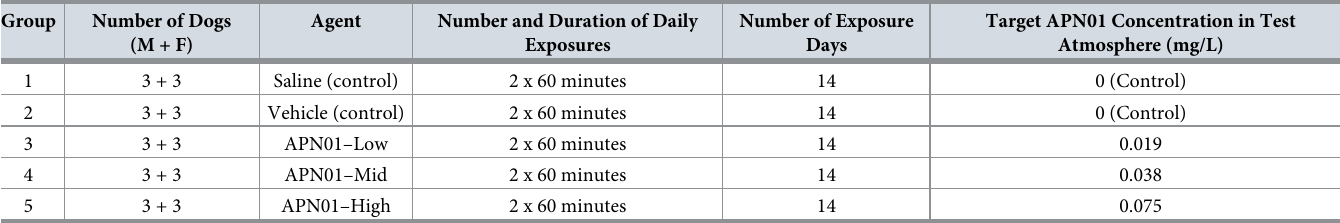
Table 1. Toxicology design. Nebulized APN01 was administrated twice a day for 14 consecutive days at a low APN01 concentration (0.019 mg/L), a mid concentration (0.038 mg/L), and a high APN01 concentration (0.075 mg/L) for each single administration. The high APN01 dose was demonstrated to be the maximum feasible concen- tration (MFC), obtained by aerosolizing the i.v. formulation in a dose range-finding study.